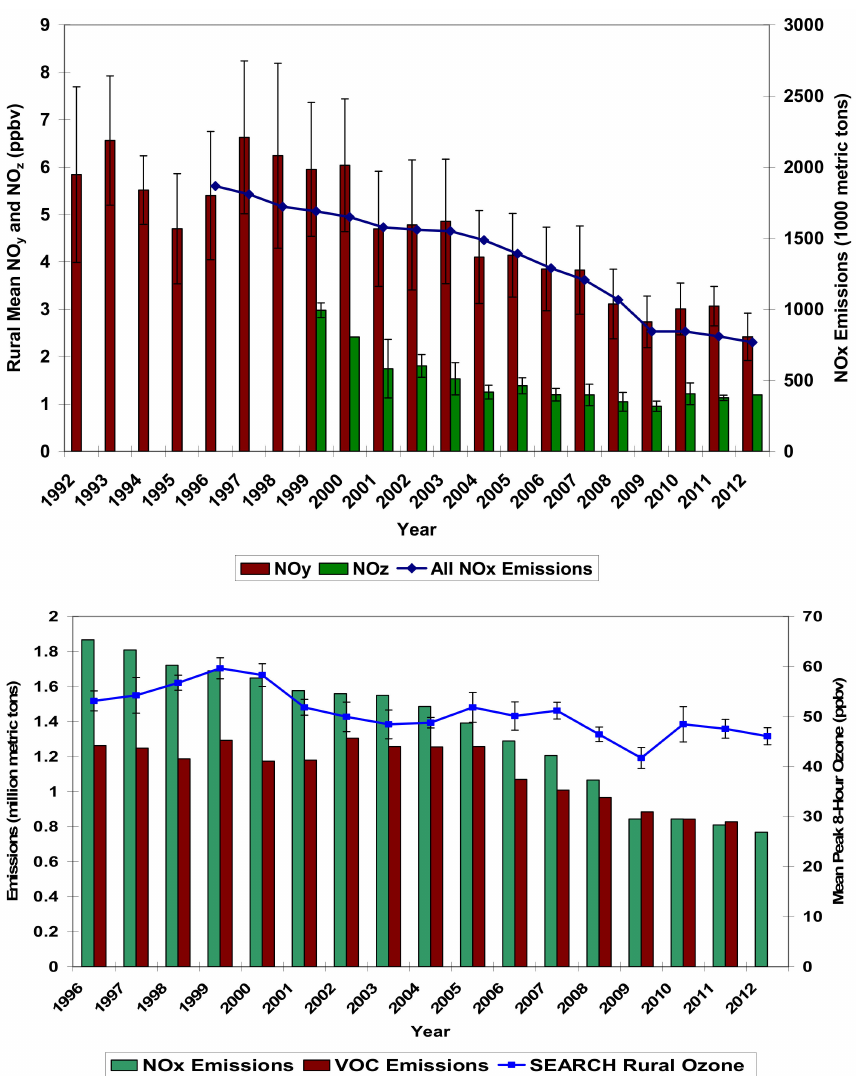
Figure 4. Example of indicator species, NO x , NO y and the annual average O 3 reductions accom- panying emission reductions in southeastern U.S., including Atlanta, Georgia and Birmingham, Alabama